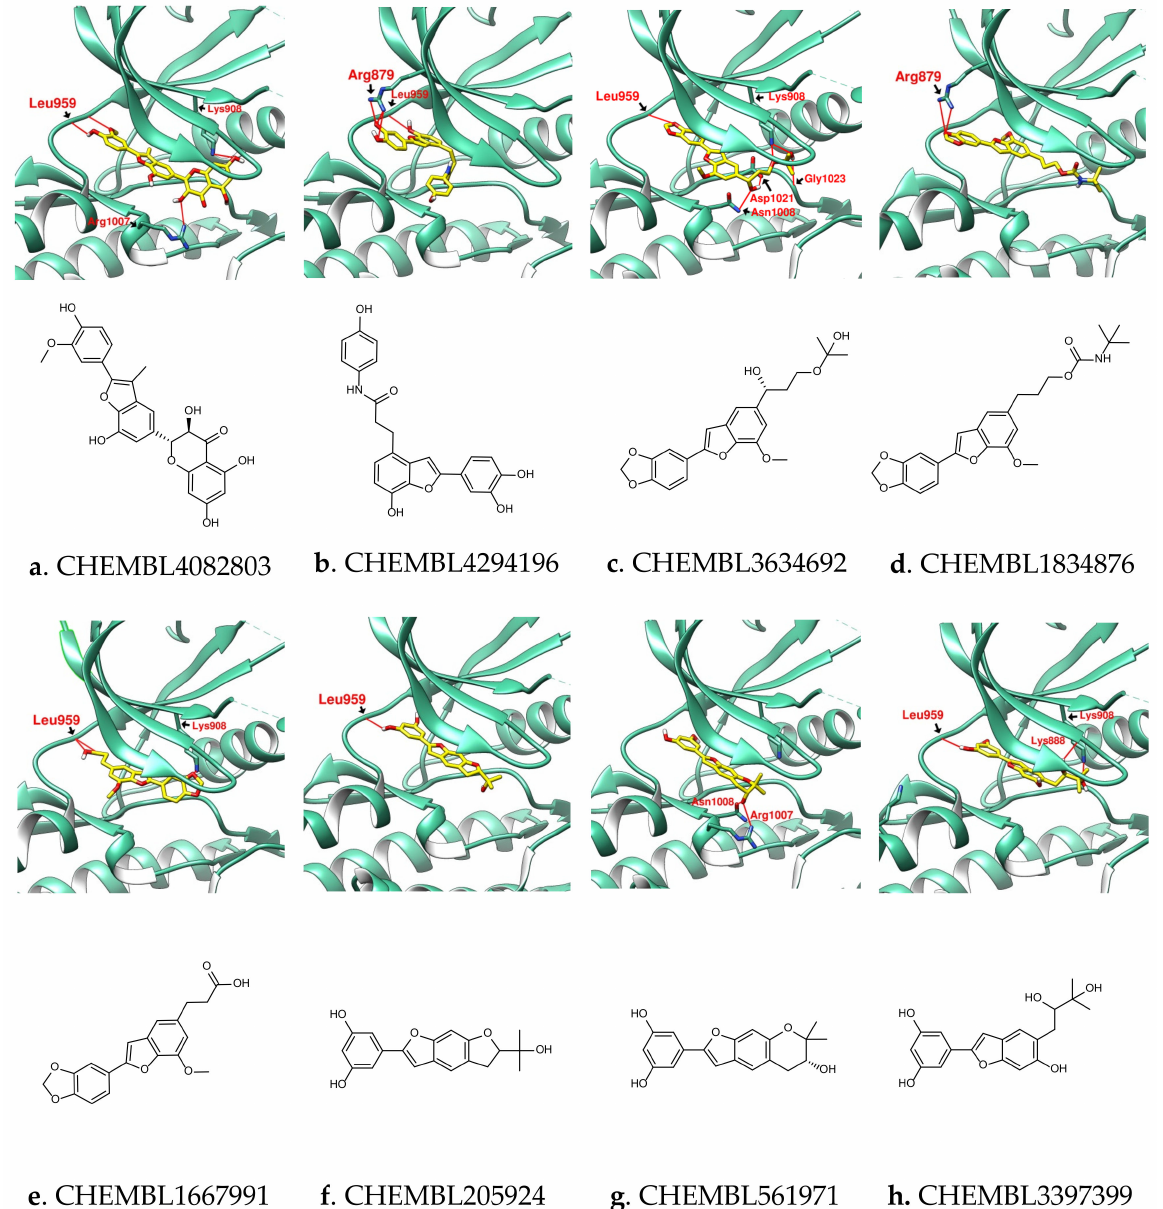
Figure 7. ( a – h ) Benzofuran derivatives with biological activity and JAK inhibition potential obtained by searching for “SalC” with SwissSimilarity. Hydrogen bonds were shown as red lines with amino acid residue